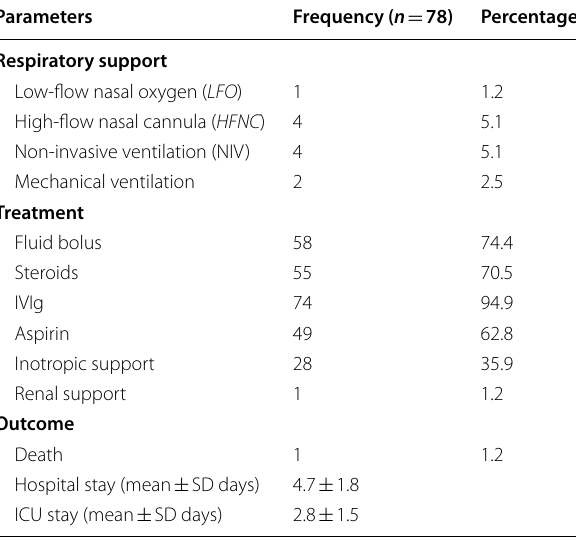
Table 4 Distribution of treatment modalities and outcome